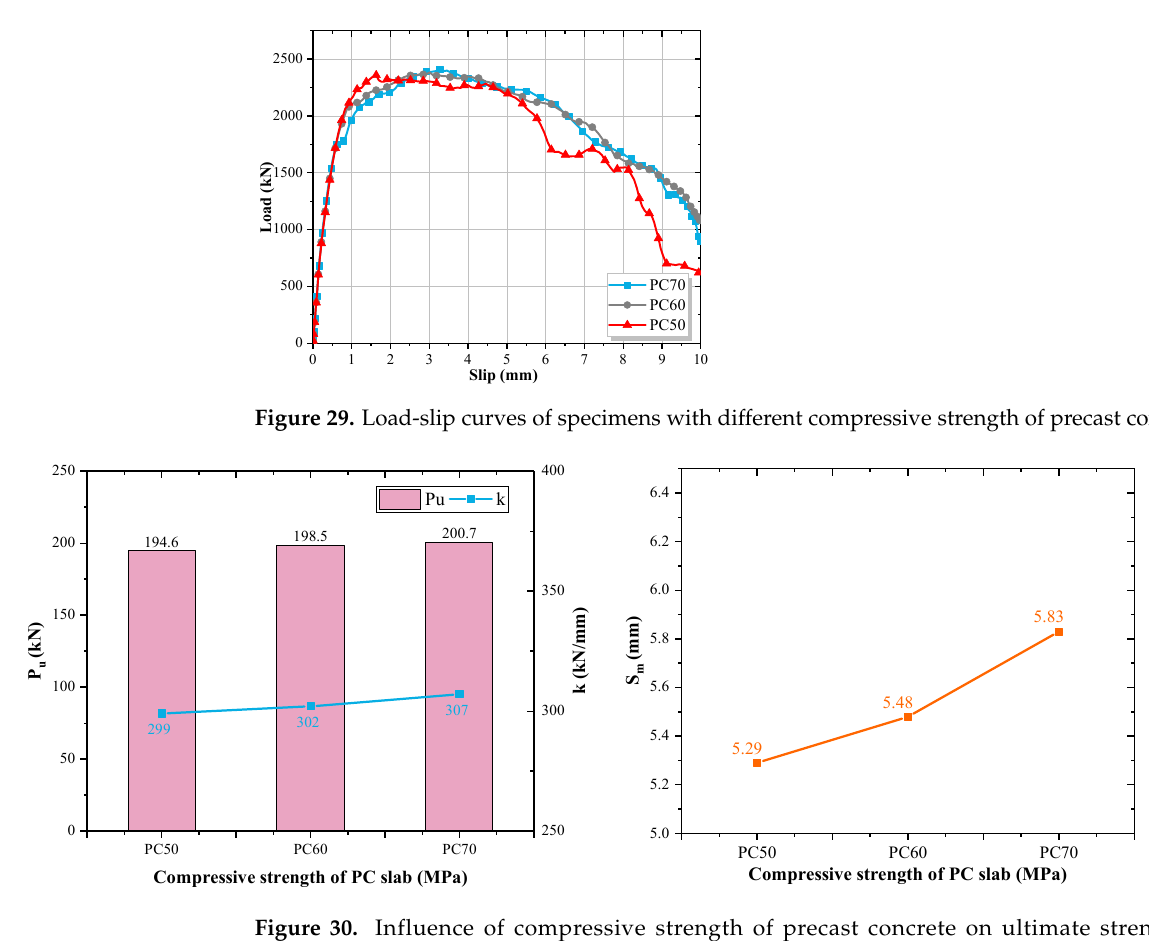
28 of 30 Figure 28. Damage distribution of the specimen at peak load: ( a ) compressive damage of concrete; ( b ) mises stress of studs. 5.5. Parameter 5: Compressive Strength of Precast Concrete The load-slip curves of the specimens with precast concrete slabs of different com- pressive strengths are illustrated in Figure 29. It can be seen from the curves that the dif- ference between the specimens in the elastic stage is minor, whereas in the plastic stage